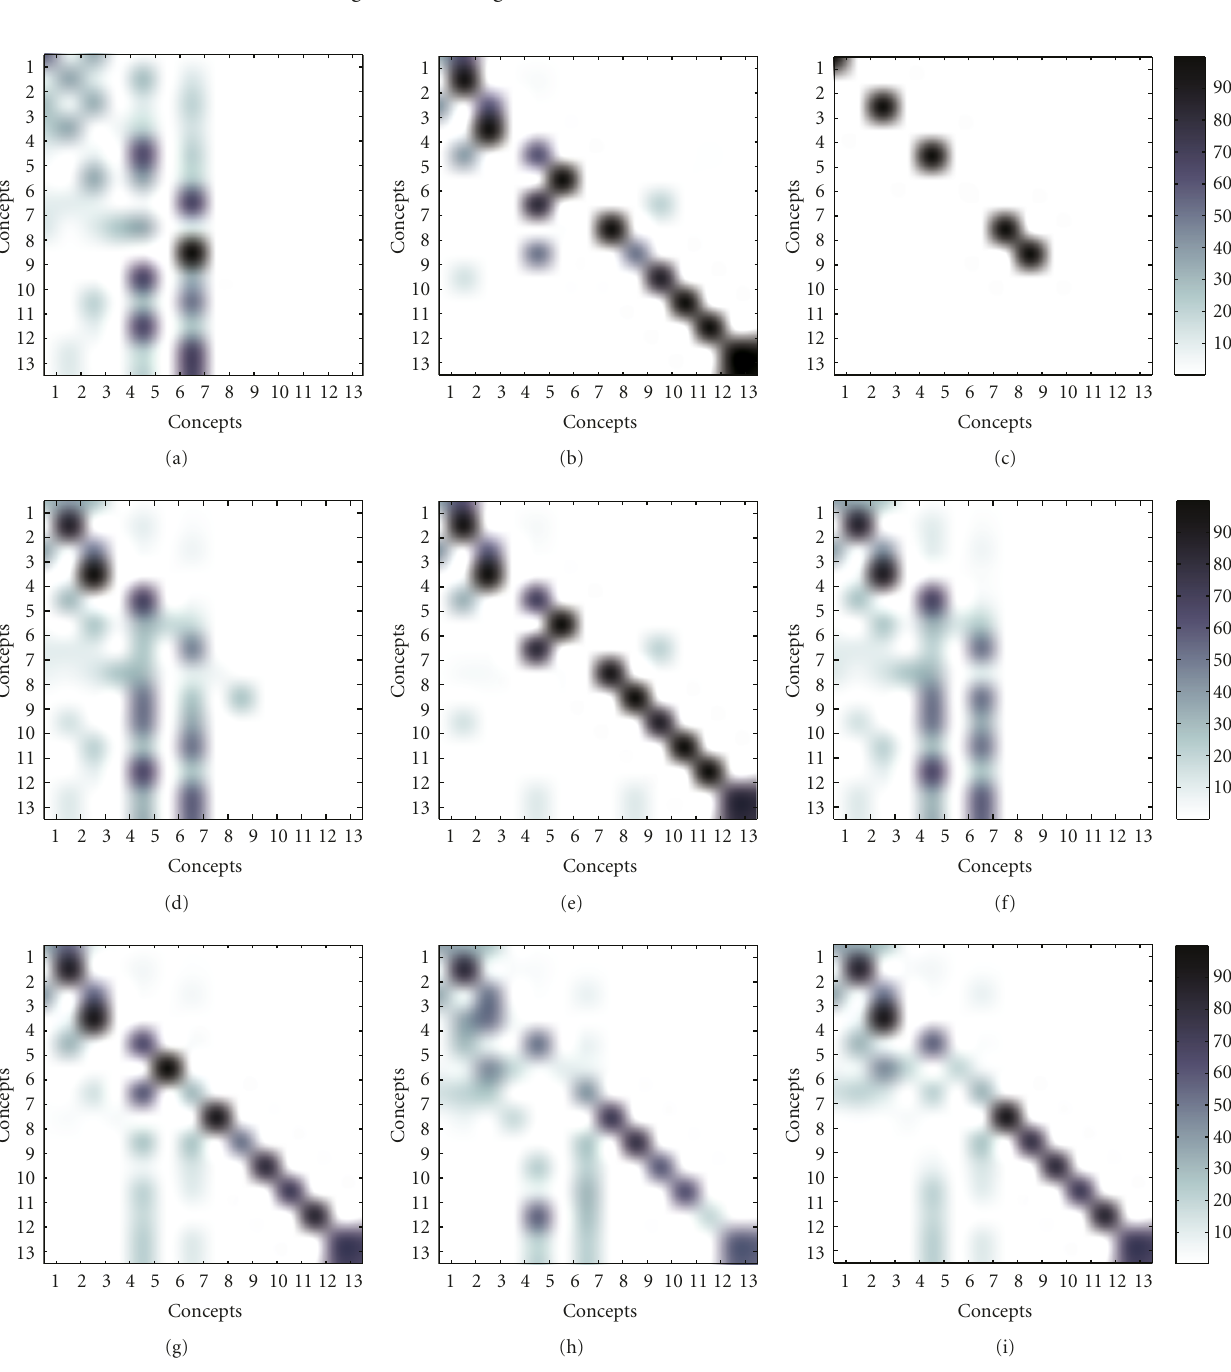
Figure 10: Confusion Matrices for the 13 concepts of Table 1—dataset restricted to shots for which more than one single modality analysis results exist. (a) Visual Classification, (b) ASR linguistic analysis, (c) OCR linguistic analysis, (d) Borda Count method [14], (e) Borda Fuse method [14], (f) method of [38], (g) Generalized Concept Overlay with μ ( s j , s m ) = const, and (h) Generalized Concept Overlay with τ ( s j , s m ) = const, (i) Generalized Concept Overlay.